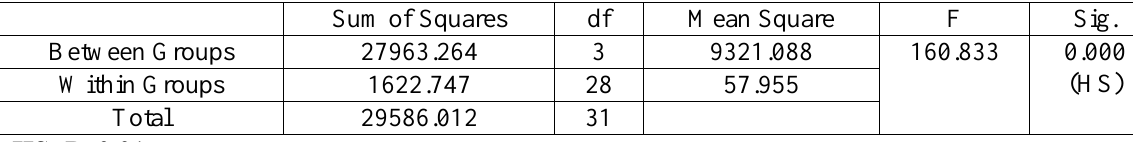
Table 2: ANOVA test among the groups. Sum of Squares Mean Square Between Groups